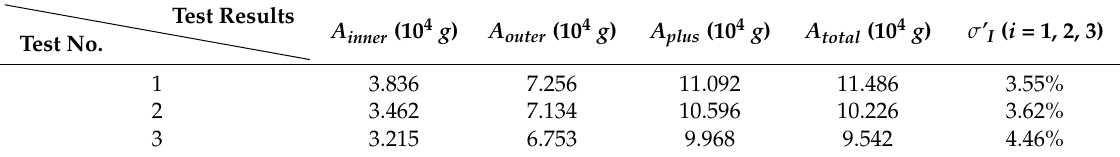
Table 3. Peaks of the accelerations of A inner , A outer , A plus , and A total , and the dynamic linearity of the measured